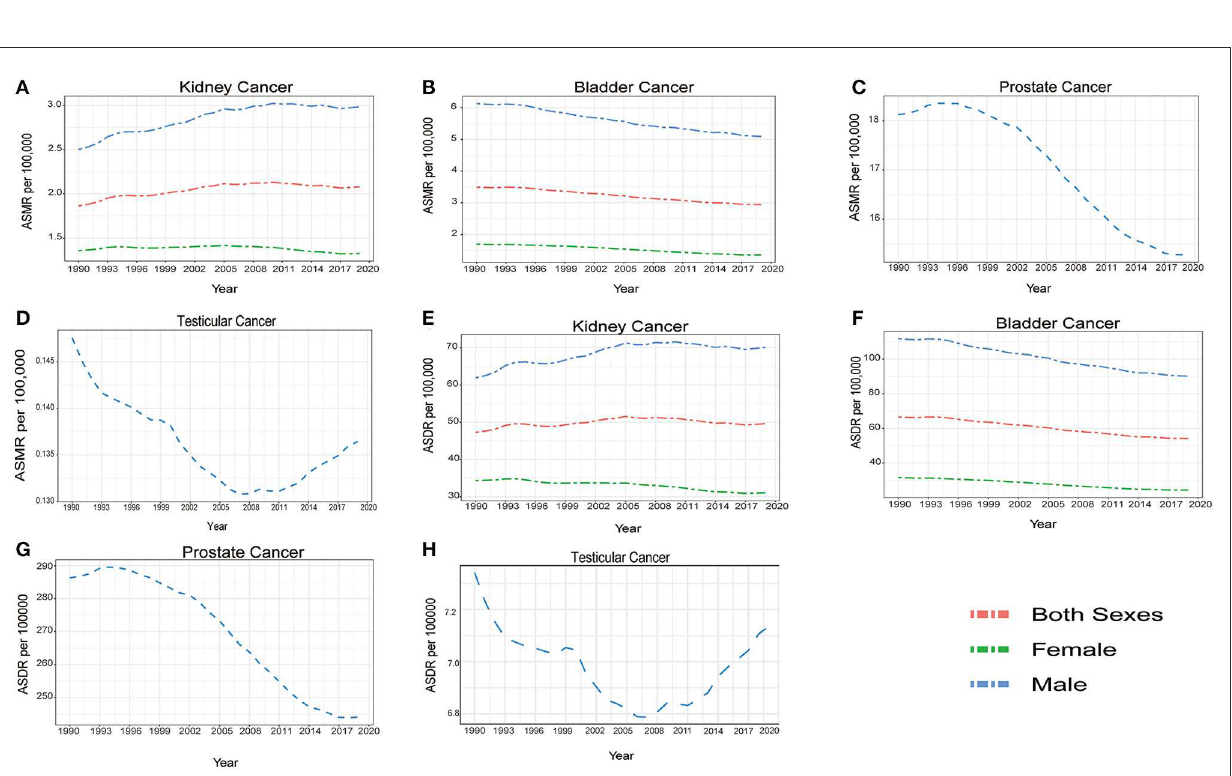
FIGURE4 The temporal trends of global age standardized mortality rate (ASMR) and age standardized disability adjusted life year rate (ASDR) by sexes for kidney cancer (A, E) bladder cancer (B, F) prostate cancer (C, G) and testicular cancer (D, H) from 1990 to